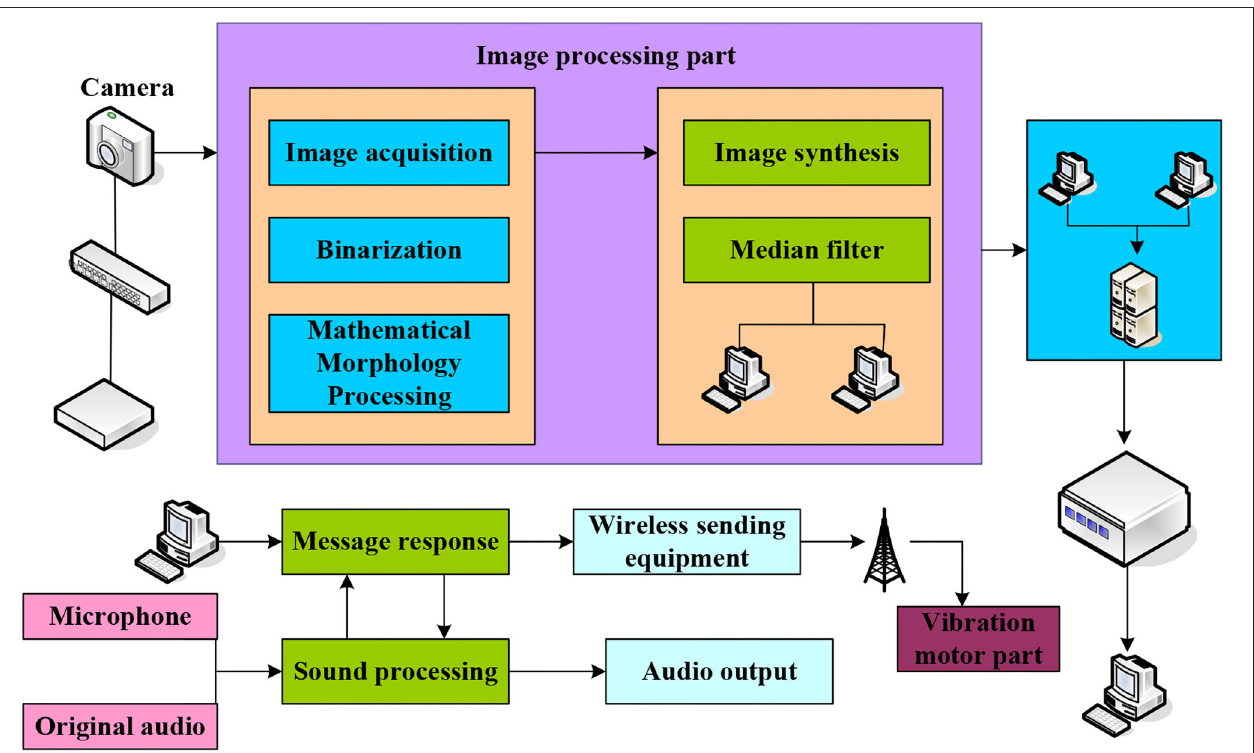
FIGURE 1 | The overall structure design of the system.